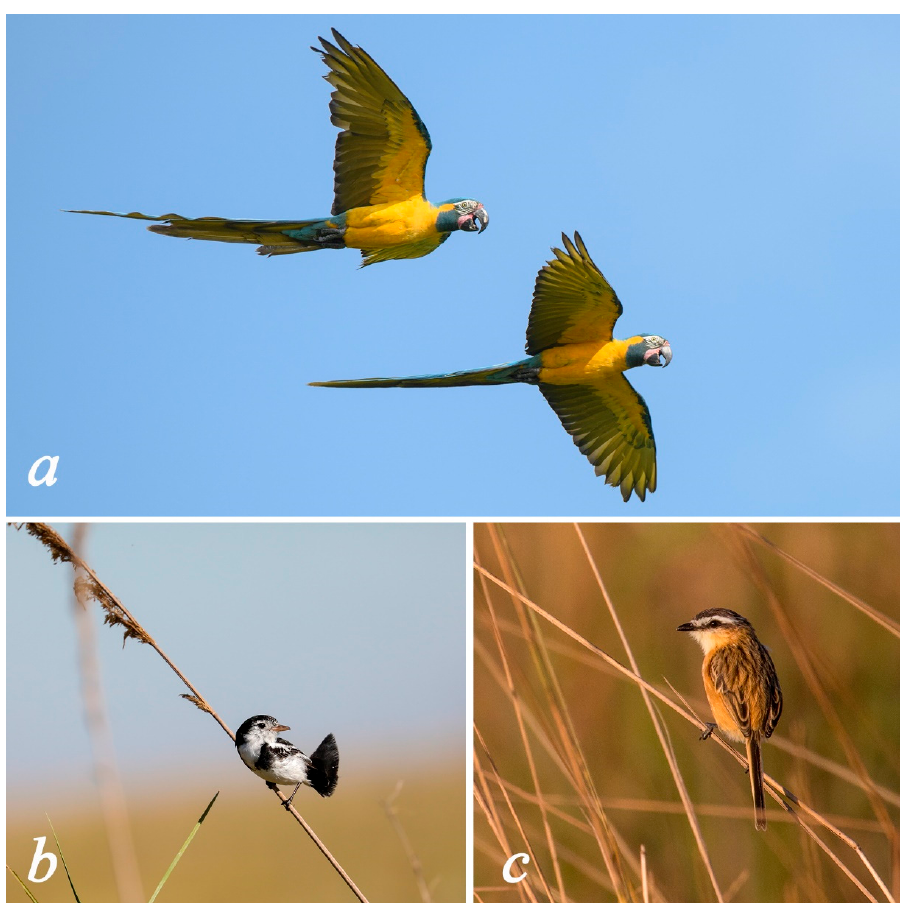
Figure 2. Some priority species for conservation, whose distribution areas were most affected by wildfires during the period 2001–2020: ( a ) Blue-throated Macaw Ara glaucogularis (Gerrit Vyn/Asociación Armonía), ( b ) Cock-tailed Tyrant Alectrurus tricolor (Lennart Verheuvel/Asociación Armonía), and ( c ) Sharp-tailed Tyrant Culicivora caudacuta (Lennart Verheuve/Asociación Armonía). The distribution maps developed for the Birds of Bolivia Field Guide [33] were used in this study. Each species’ map was constructed under a deductive species distribution modeling approach based on expert opinion [35]. This procedure reduced the overestima- tion of the resulting maps (false-positive errors). The data used for the development of the maps were extracted from Asociación Armonía’s distributional database for Bolivian birds, which contains >120,000 occurrence records from >1400 georeferenced localities [35]. Each map was developed based on occurrence records in vegetation types [36], ecore- gions [31] and the known or expected elevational range, using NASA’s Shuttle Radar To- pography Mission (SRTM) digital elevation model of 90 m (0.81 ha) to remove grid cells above and below the known or expected upper or lower elevation limit, respectively [35].